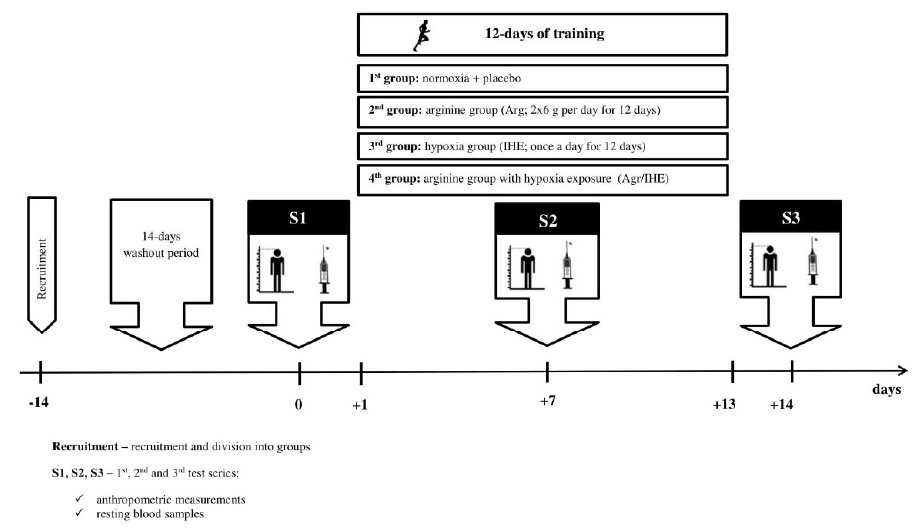
Figure 1. Illustration of the study